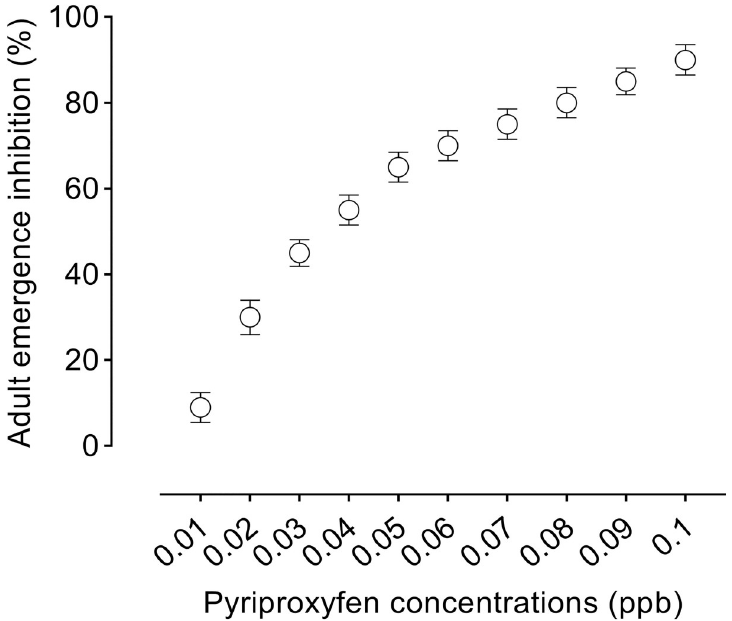
Fig 1. Adult emergence inhibition in Ae . aegypti in response to pyriproxyfen